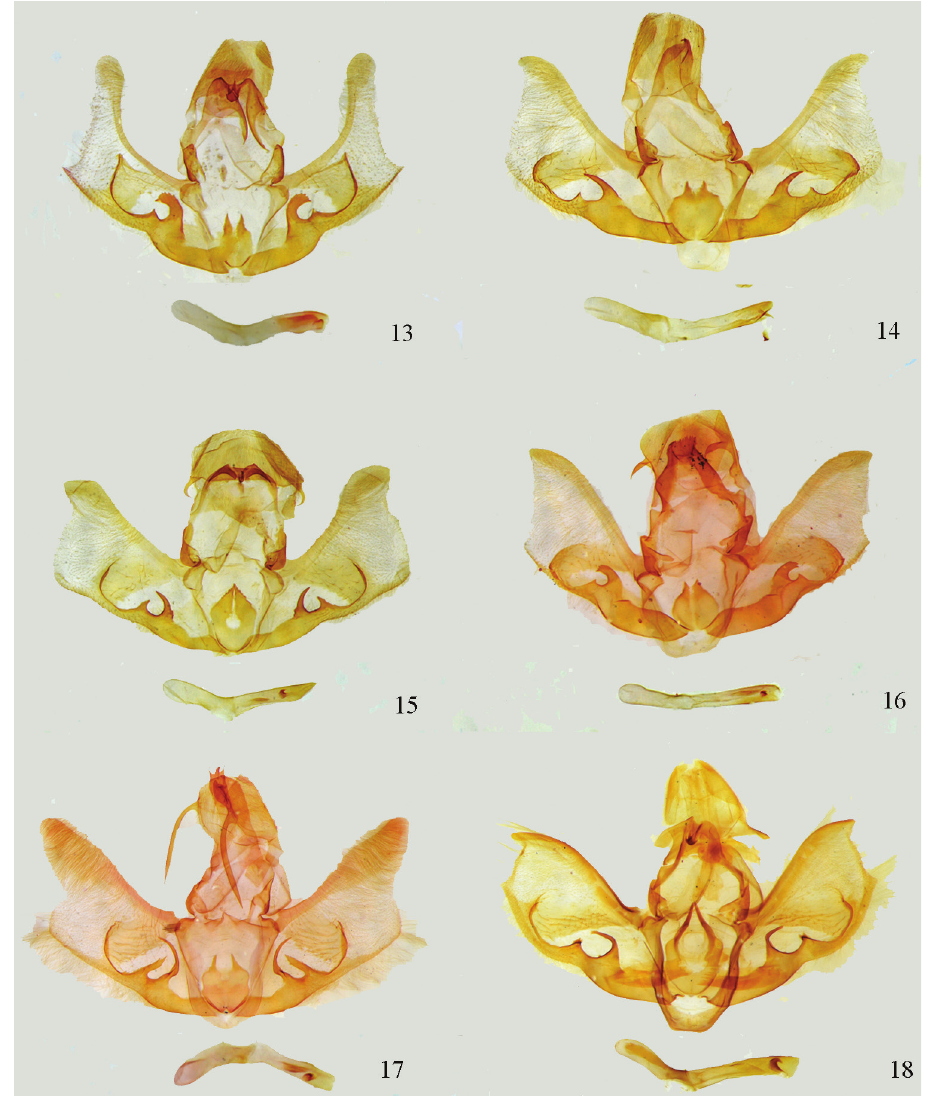
Figures 13–18. Male genitalia. 13 Lista angustusa sp. n., holotype, gen. slide no. Ep549 14 L. ficki (Christoph , 1881), gen. slide no. Ep523 15 L. gilvasa sp. n., holotype, gen. slide no. Ep524 16 L. haral- dusalis (Walker, 1859), gen. slide no. Ep527 17 L. insulsalis (Lederer, 1863), gen. slide no. Ep511 18 L. longifundamena sp. n., holotype, gen. slide no. Ep122.